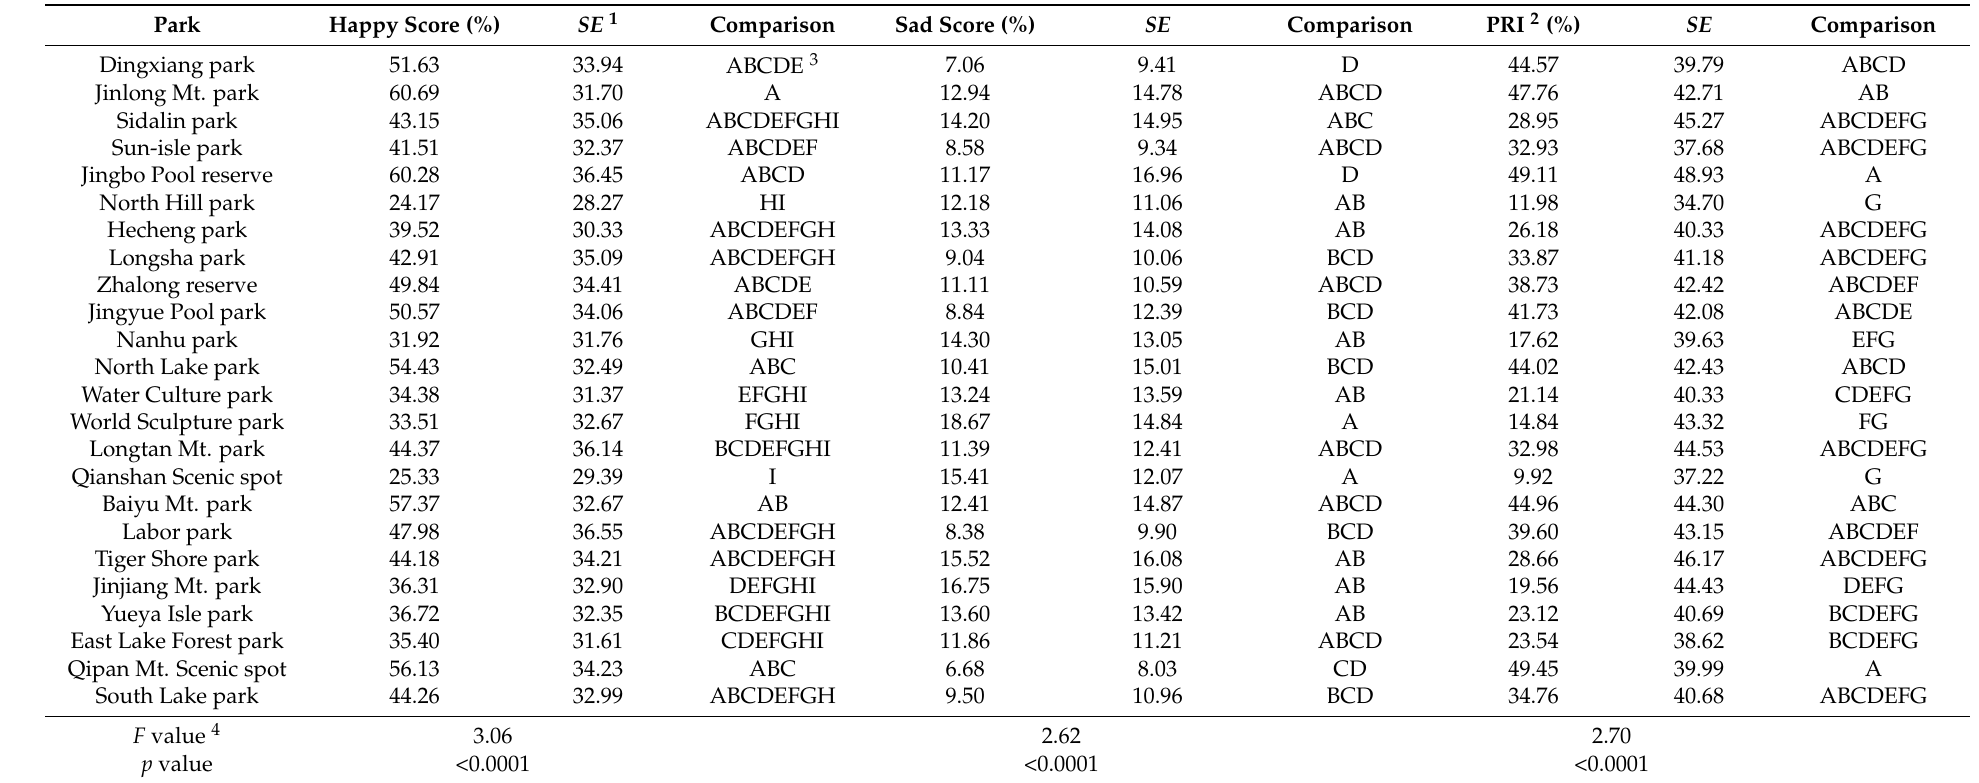
Table 3. Difference of facial expression scores for visitors in urban forest parks at Northeast